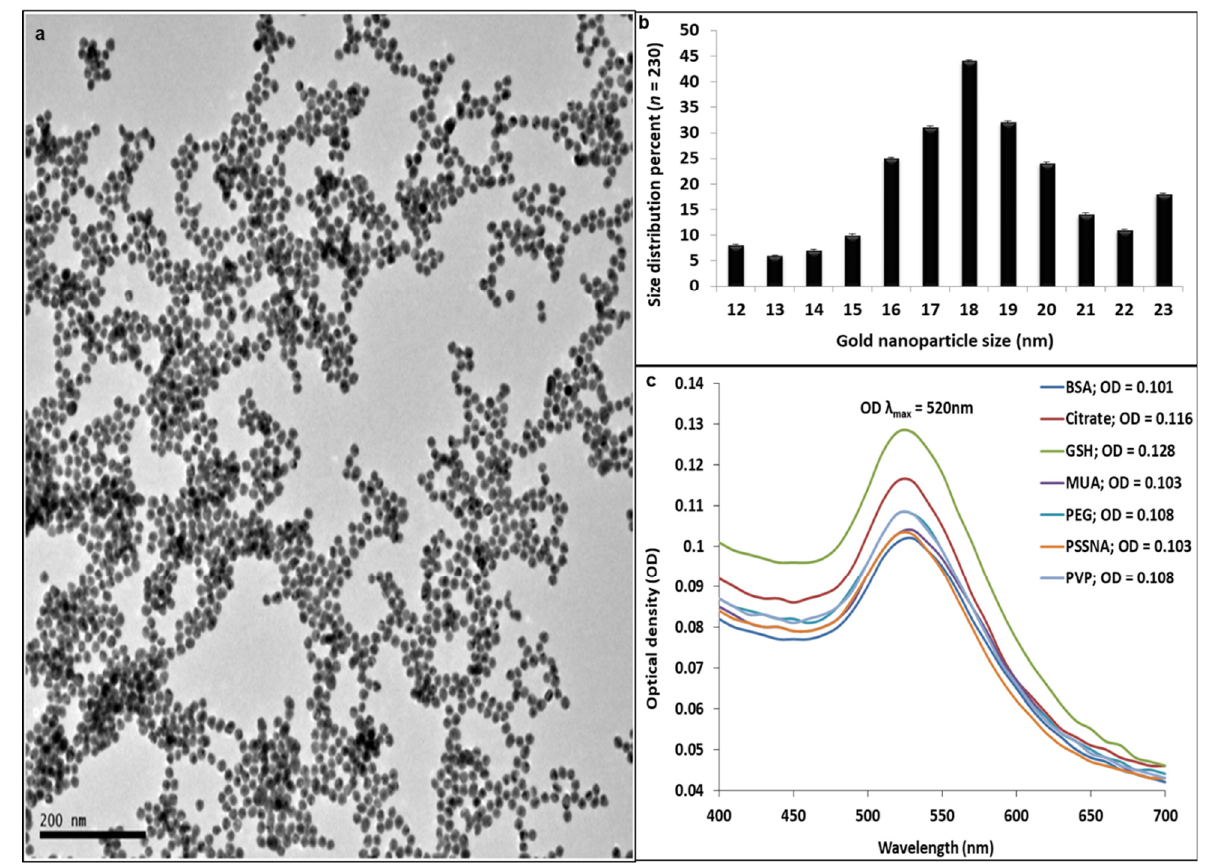
Figure 2. ( a ) High-resolution transmission electron microscopy micrograph of the citrate capped GNPs. ( b ) Percentage of GNP size distribution on 230 particles analyzed. ( c ) UV-Vis spectra of the functionalized GNP-ligands post sample clean-up. Table 1. Summary of the GNP-ligand characteristics.